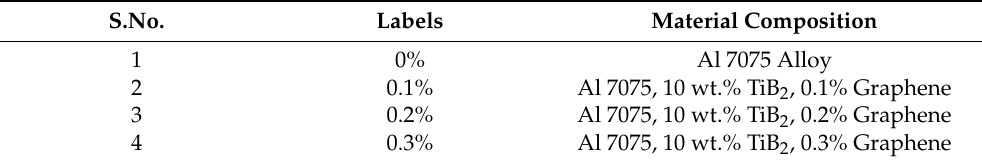
Table 2. Material